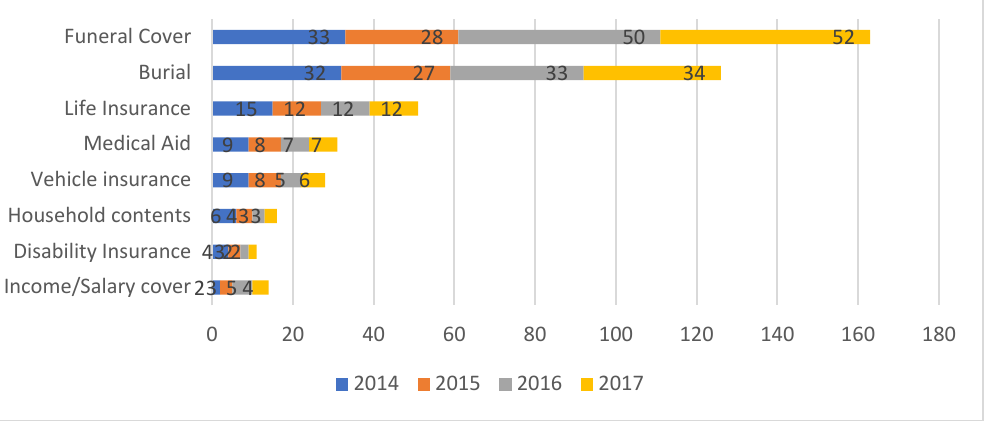
Figure 7. Proportion of adults insured by type. Source of data: (FinMark Trust 2016, 2018). Figure 8. Proportion of adults insured by type. Source of data: (FinMark Trust 2016,